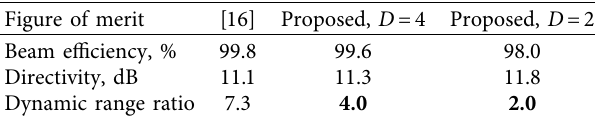
numbers of elements and beamwidth of 12 ° , obtained by mini- mization of SLP and constrained DRR. Black curve indicates maximum DRR, which is achieved in DRR-unconstrained design. Table 6: Properties of proposed pencil beam arrays with 16 ele- ments and beamwidth of 20 ° , compared with array having maxi- mum efciency and unconstrained DRR [16]. Improvements are highlighted in